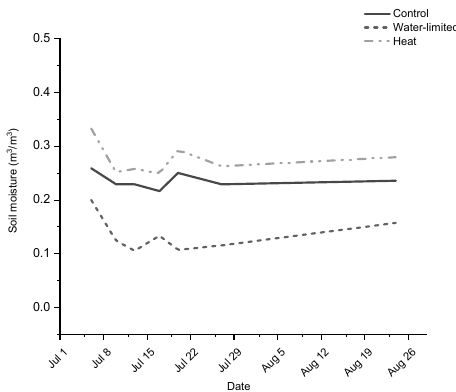
Figure 1. Mean soil volumetric water content during the growing season for control, water-limited, and elevated soil temperature treatments.